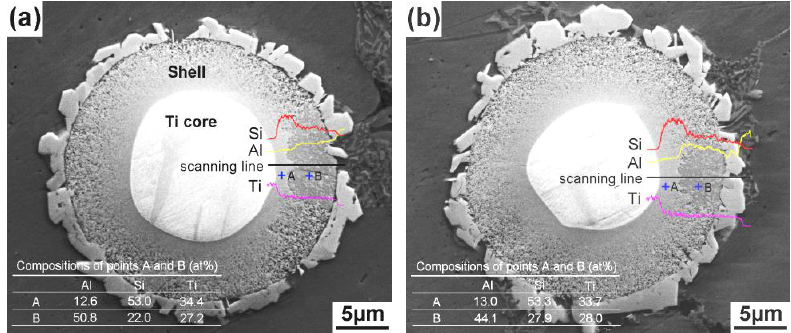
Figure 7. SEM images and energy dispersive spectroscope (EDS) results of reinforcing particles in the composites thixoformed under mold temperatures of ( a ) 150 °C, ( b ) 400 °C.